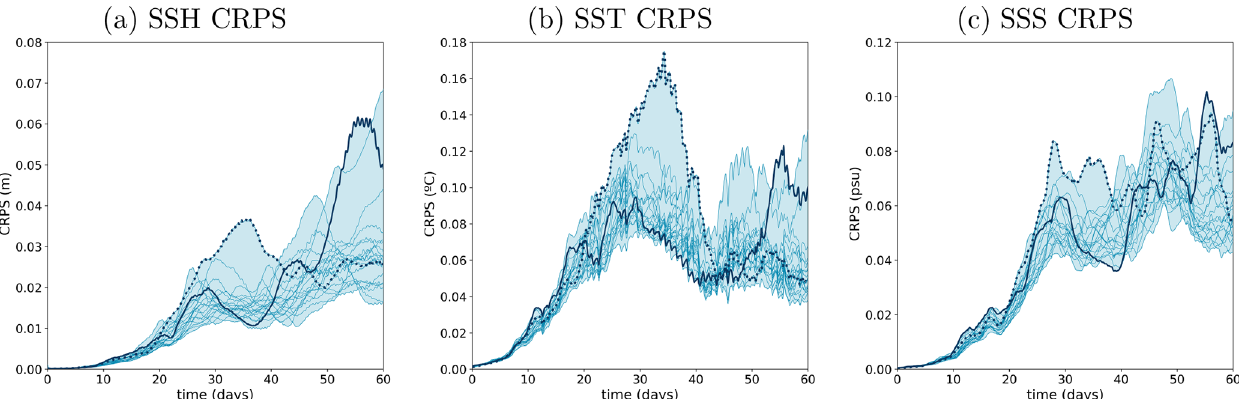
Figure 8. Time evolution of the CRPS score ( y axis) for SSH (meters), SST (degree Celsius) and SSS (psu) from experiment ENS-CI. The score is computed for each of the 20 permuted cases (thin lines) taking an ensemble member as the reference truth and the rest of the members as the ensemble forecast. The blue shading represents the minimum-to-maximum envelop of the 20 scores computed for the experiments. Two example lines are plotted thicker (solid and dotted lines) in each panel to illustrate how individual scores can evolve with